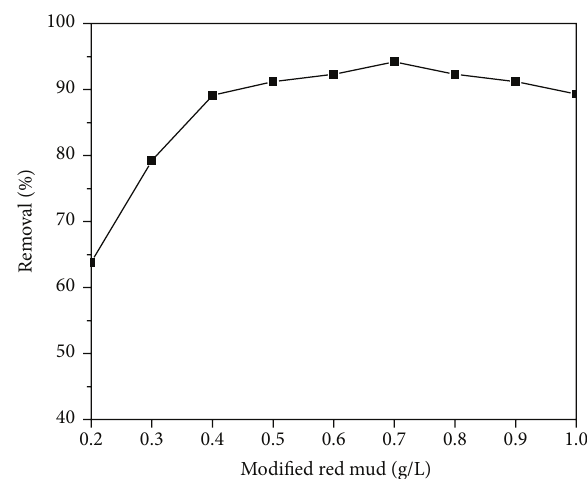
Figure 7: Effect of modified red mud amount on the removal percentage of MO. Experimental conditions: irradiation time of 50 min, 5 × 10 −5 mol/L